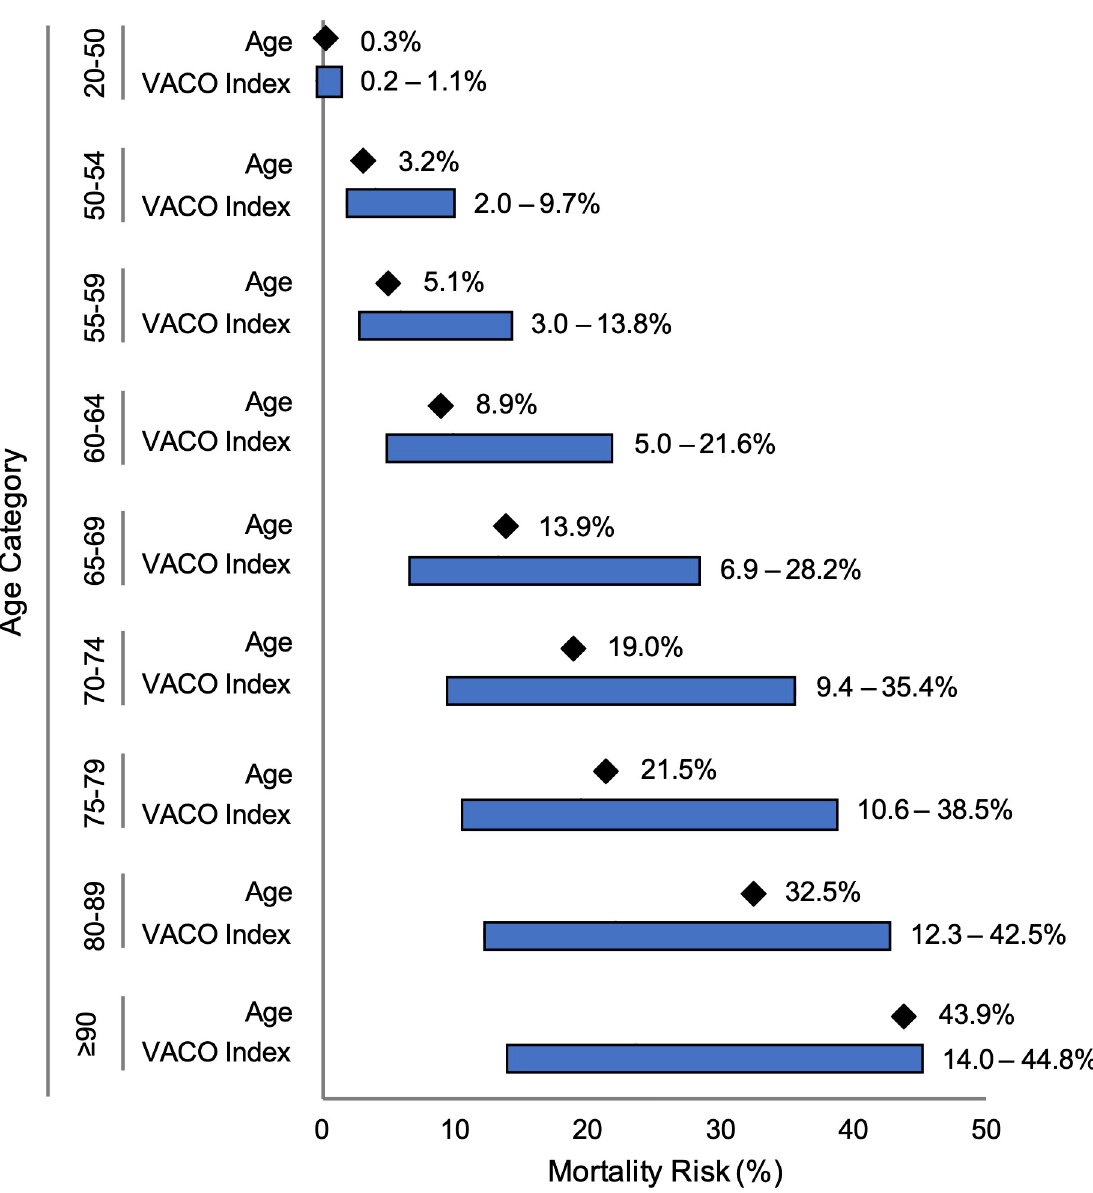
Fig 5. Range of 30-day mortality predictions from age alone and VACO Index. Bar graphs demonstrating the additional variation in mortality prediction provided by the VACO Index over age alone across age categories in the combined validation cohort (n = 9,642). The diamonds indicate predicted 30-day mortality within each age category when only age is used to generate the predicted value. The bars show the range of predicted 30-day mortality within the same age category provided by the VACO Index, where age is supplemented with sex and